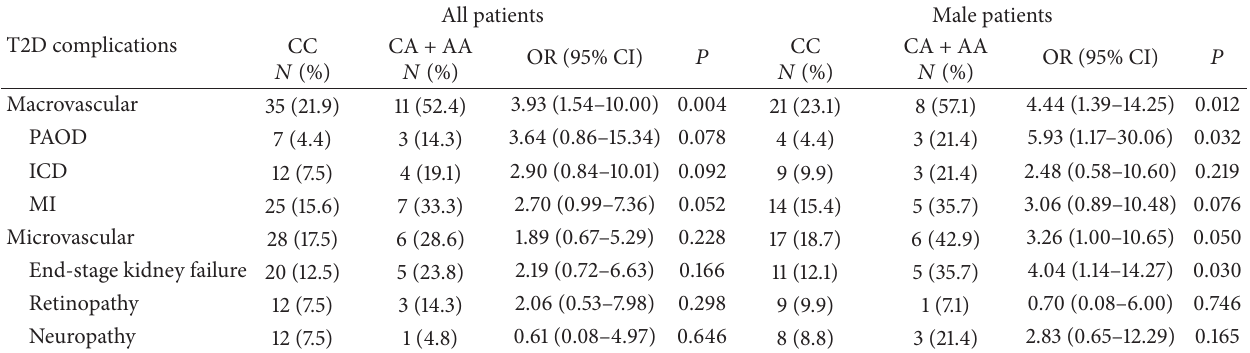
Table 2: The association of NLRP3 rs35829419 with the risk for macro- and microvascular complications in type 2 diabetes patients. All T2D complications